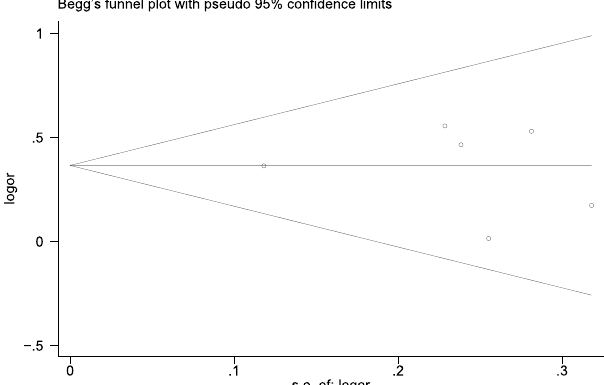
Figure 4. Funnel plot for the recessive model to analyze publication bias of the association of the rs987107 polymorphism with MS